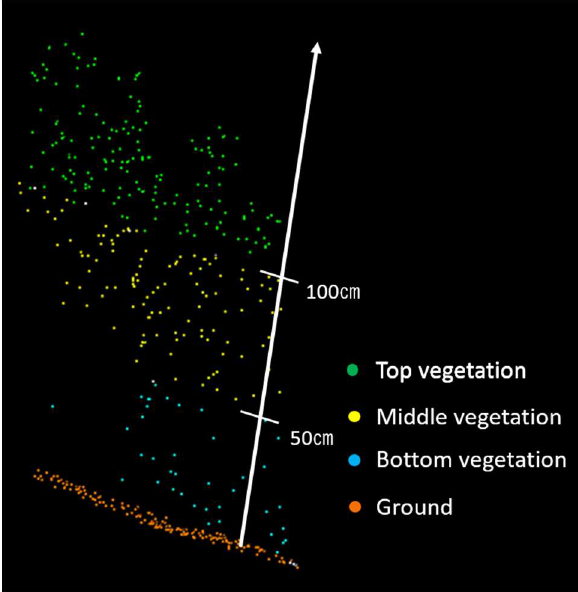
Figure 3. LiDAR point cloud classification. LiDAR point cloud